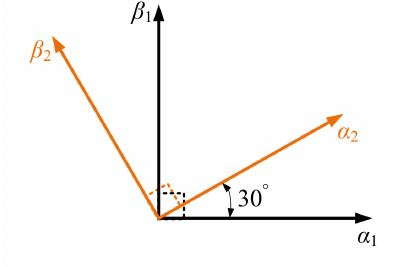
Figure 5. The spatial position of ( α 1 , β 1 ) and ( α 2 , β 2 )